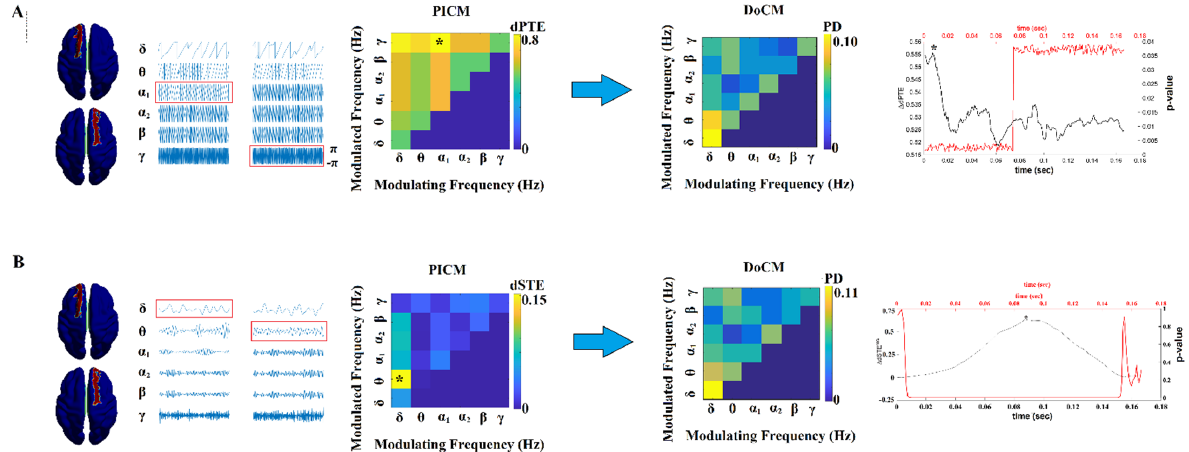
Figure 2. Schematic illustration of the approach employed to identify the dominant coupling mode between two AAL atlas ROIs (left superior frontal gyrus and right superior frontal gyrus) for an epoch (t 1 ) during a resting-state MEG recording. In this example, the causal interdependence between band-passed signals from the two virtual sensors was indexed by ( A ) dPTE and ( B ) dSTE. In this manner, both dPTE and dSTE were computed between the activity of the two virtual sensors either for same-frequency oscillations (within-frequency coupling, e.g., δ to δ ) or between different frequencies (cross-frequency coupling, e.g., δ to θ ). All 21 estimations (within-frequency (6) + cross-frequency coupling (15)) are called potential intrinsic coupling modes (PICMs). PICMs are tabulated in a matrix of size frequencies × frequencies, wherein the main diagonal, the within-frequency couplings are stored, whereas in the off-diagonal, the cross-frequency couplings are tabulated. To reveal the dominant coupling modes (DoCM) per pair of virtual sensors at every epoch, we adopted surrogate data analysis to create a reference and assess whether original dPTE and dSTE values were statistically different from chance. For this example, we revealed α 1 - γ and δ - θ as dominant interactions (DoCM) for dPTE and dSTE, respectively. Following the same procedure across every pair of sensors, we ultimately estimated the probability distribution (PD) of DoCM for both estimators across the 90 virtual sensors. dPTE and dSTE revealed that the first ROI drives the second ROI in both the phase and amplitude domain, whereas the time delay was 10 ms and 86 ms, respectively, as indicated by ‘*’.